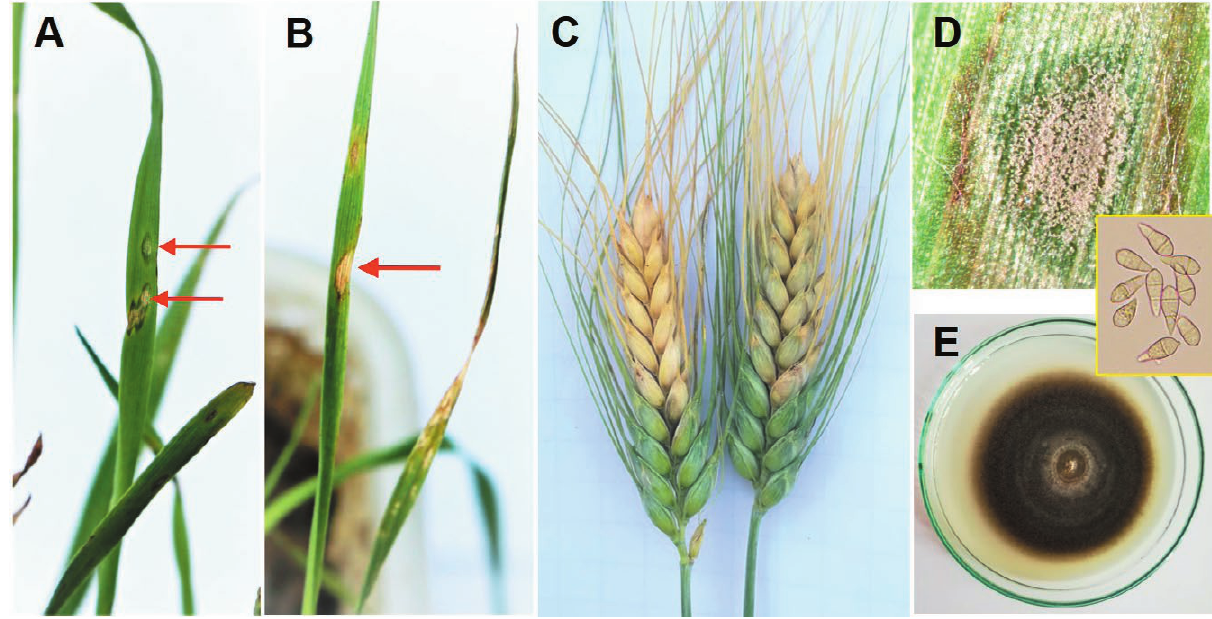
Figure 5. Results from pathogenicity tests of the Magnaporthe oryzae putative pathogen used to fulfill Koch’s postulates. (A) typical eye- shaped water-soaked lesions on seedling leaves 48–72 h after inoculation with isolate DuBWMRI1901.2A; (B) elongated lesion with a gray- ish centre and brown margins 5–7 d post-inoculation; (C) partially bleached spikes 12–14 d post-inoculation; (D) gray conidium growth on a detached leaf lesion after 24 h incubation on moist blotter paper; and (E) re-isolated inoculated isolate, and conidia